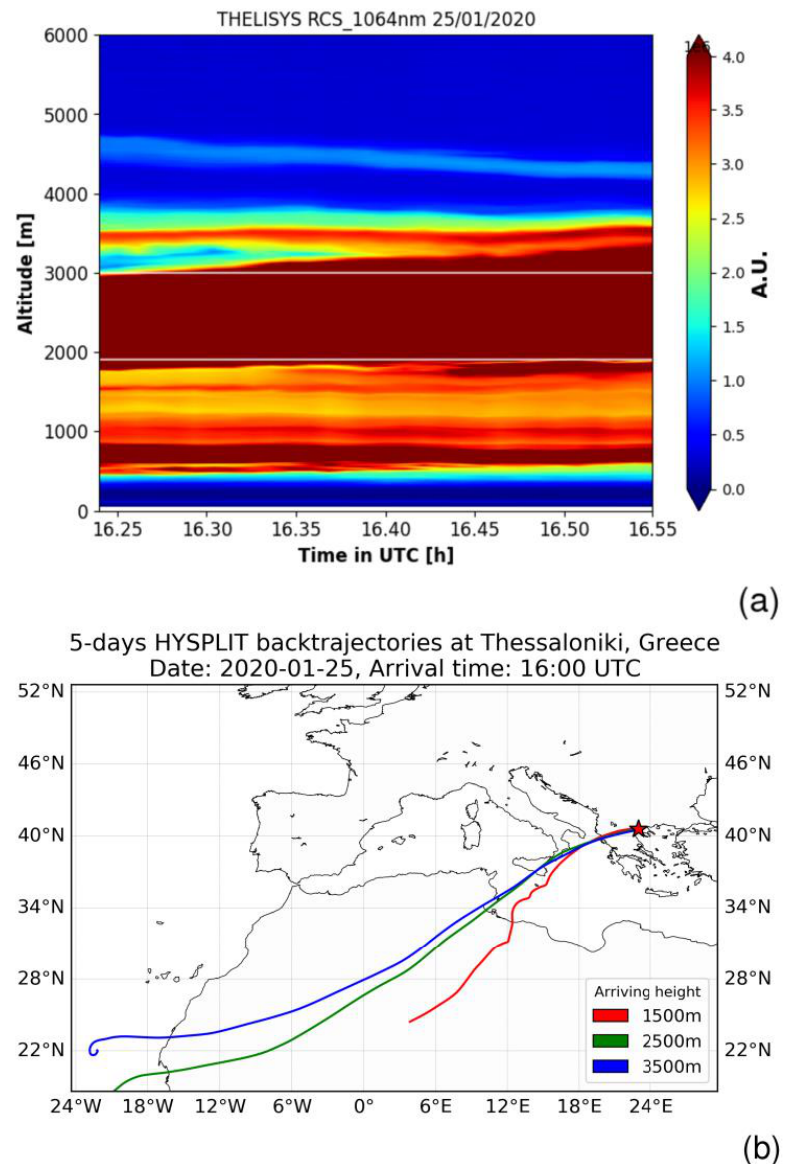
Figure 12. ( a ) Temporal evolution of the 1064 nm range corrected signal obtained with THELISYS in Thessaloniki on 25 January 2020, 16:25 – 16:55 UTC. The layer boundaries are marked with black line. ( b ) The HYSPLIT 5-day air mass backward trajectories arriving at 1.5, 2.5 and 3.5 km at 16:00 UTC at Thessaloniki.